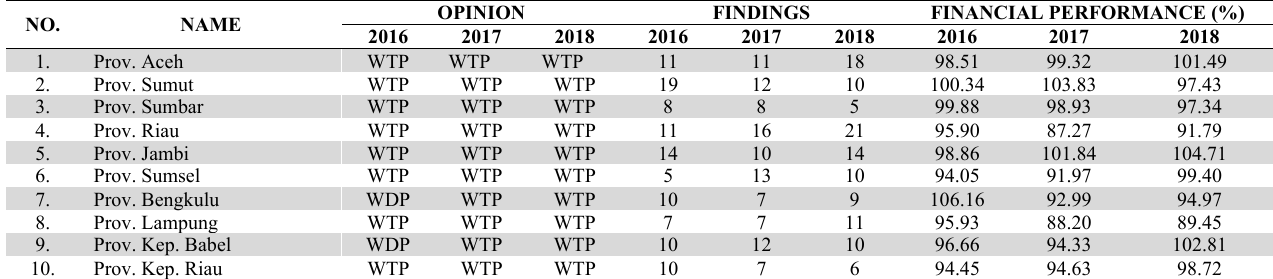
Data on BPK Audit Results in Sumatra